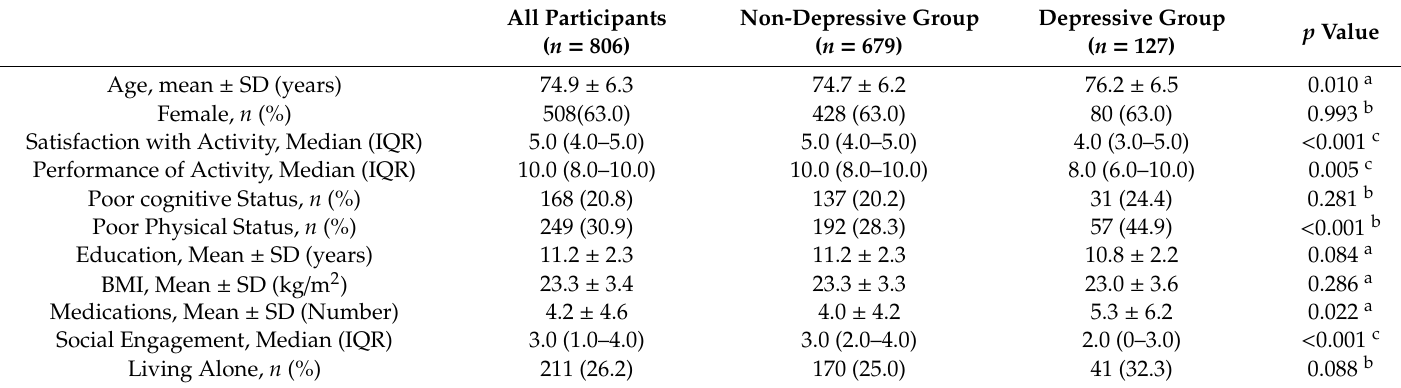
Table 1. Characteristics of the